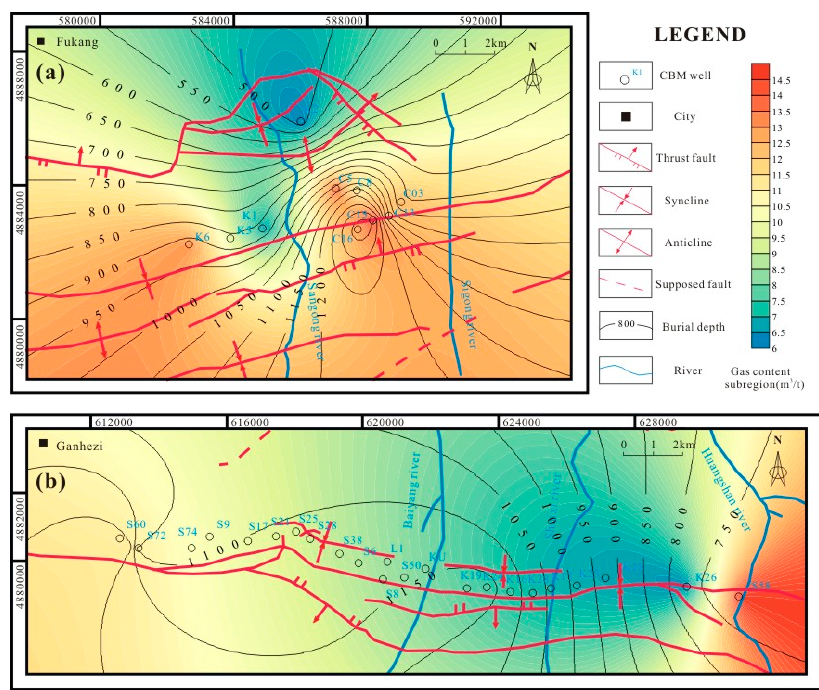
Figure 10. Relationship between gas content and burial depth of No. 43 coal seam in the Fukang syncline ( a ) and Ergonghe syncline ( b ) (units of contour lines: m for burial depth and m 3 /t for gas content with different color areas).